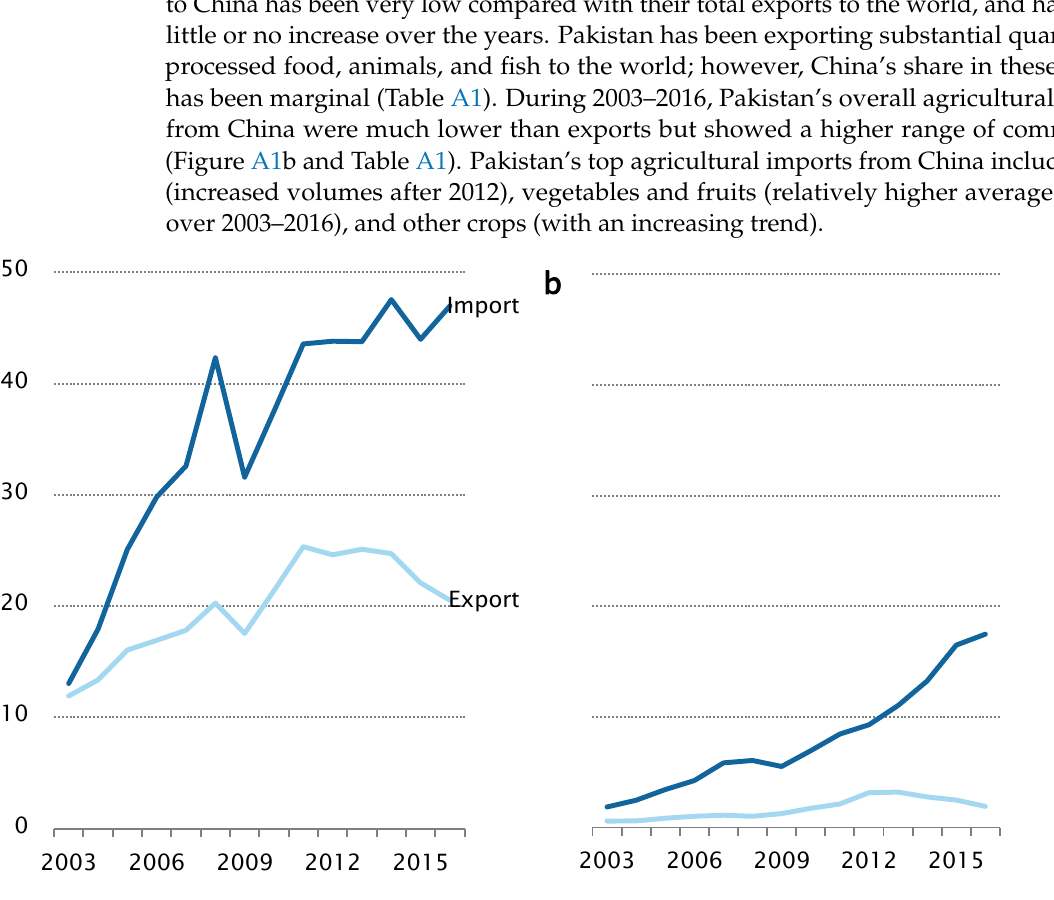
Figure A1. Pakistan’s total exports and imports during 2003–2016. ( a ), with the world; ( b ), with China. Source: Authors used data from [78] to draw this figure. Table A1. Pakistan’s trade in major agricultural commodities worldwide and with China during 2003–2016 (million